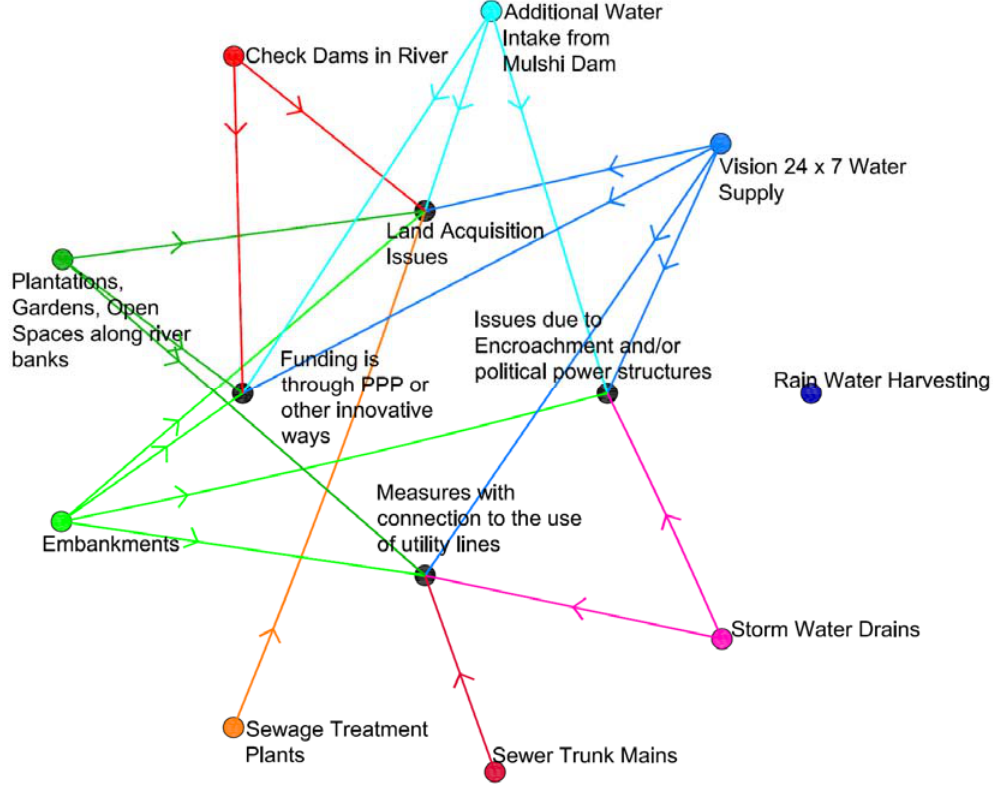
Figure 6. Common implementation bottlenecks in implementing adaptation responses. The arrows originate from the adaptation responses and terminate at the probable bottlenecks which are likely to hinder the response during planning or implementation.